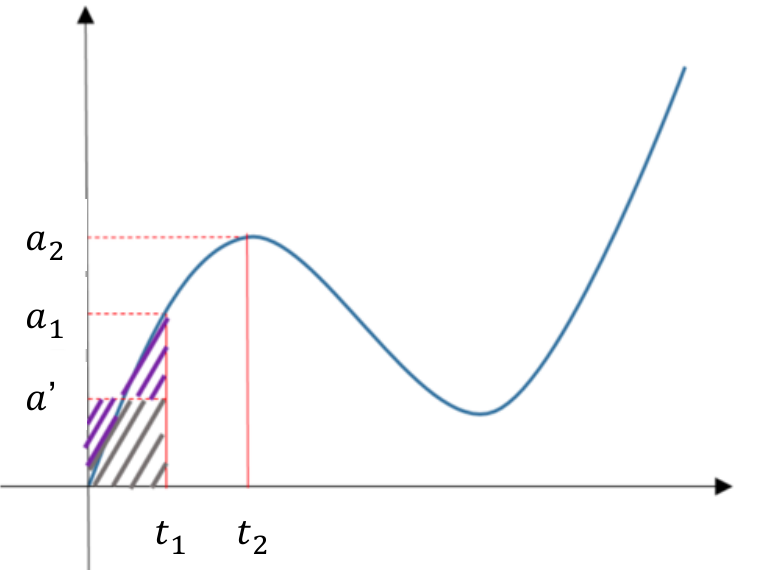
Figure 2. Illustration of integration error cancellation. The average acceleration of two adjacent sampling points is taken for